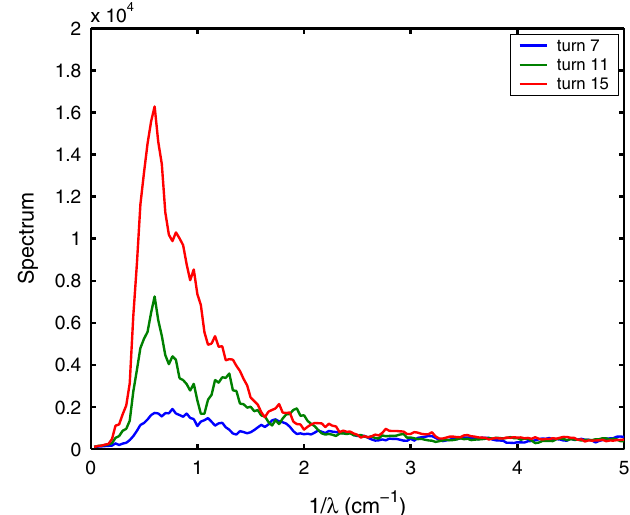
FIG. 8. (Color) Spectra of linear charge density profiles shown in Fig. 7.